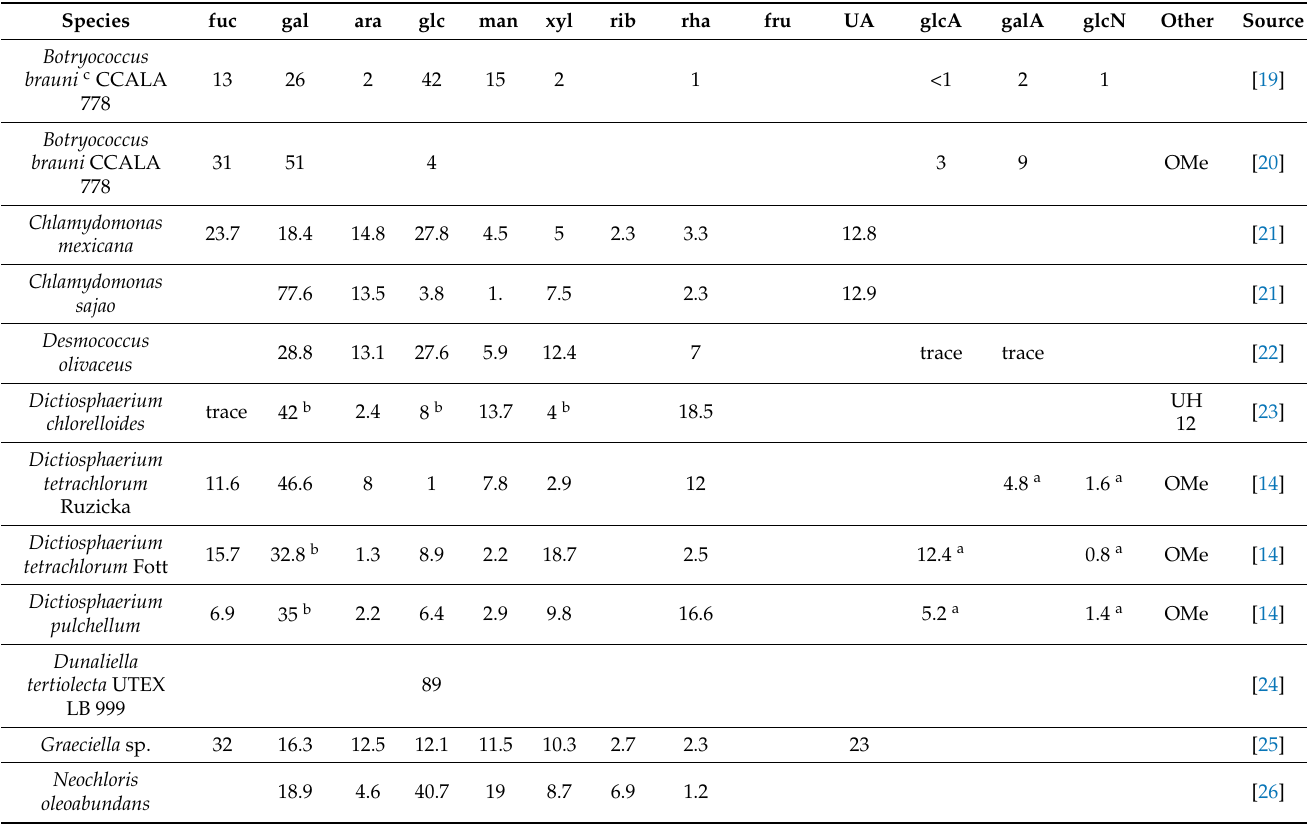
Table 1. Monosaccharide composition (% w / w ) of extracellular polymeric substances (EPS) produced by Chlorophyta. Species fuc gal